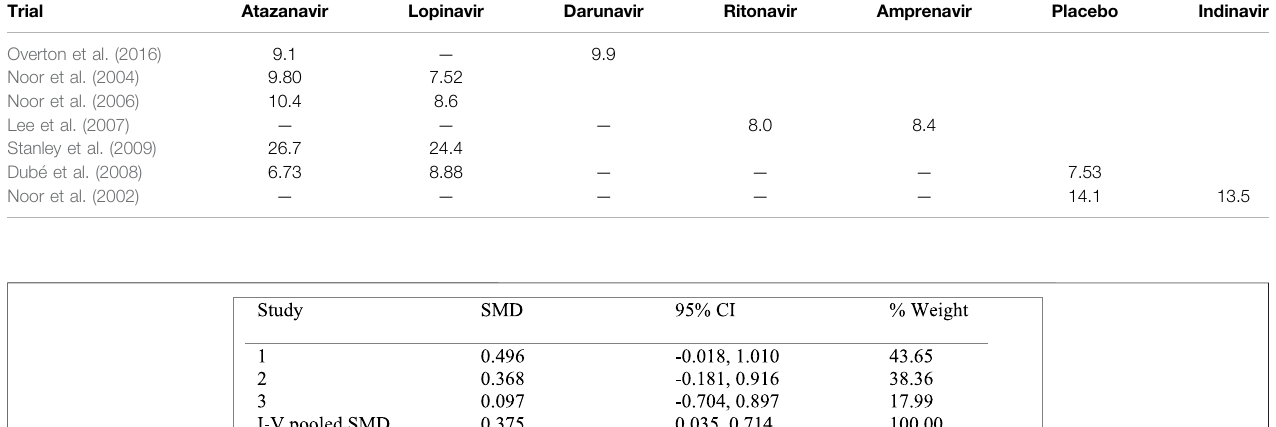
TABLE 2 | Glucose disposal rate post-intervention. Trial Overton et al. (2016)